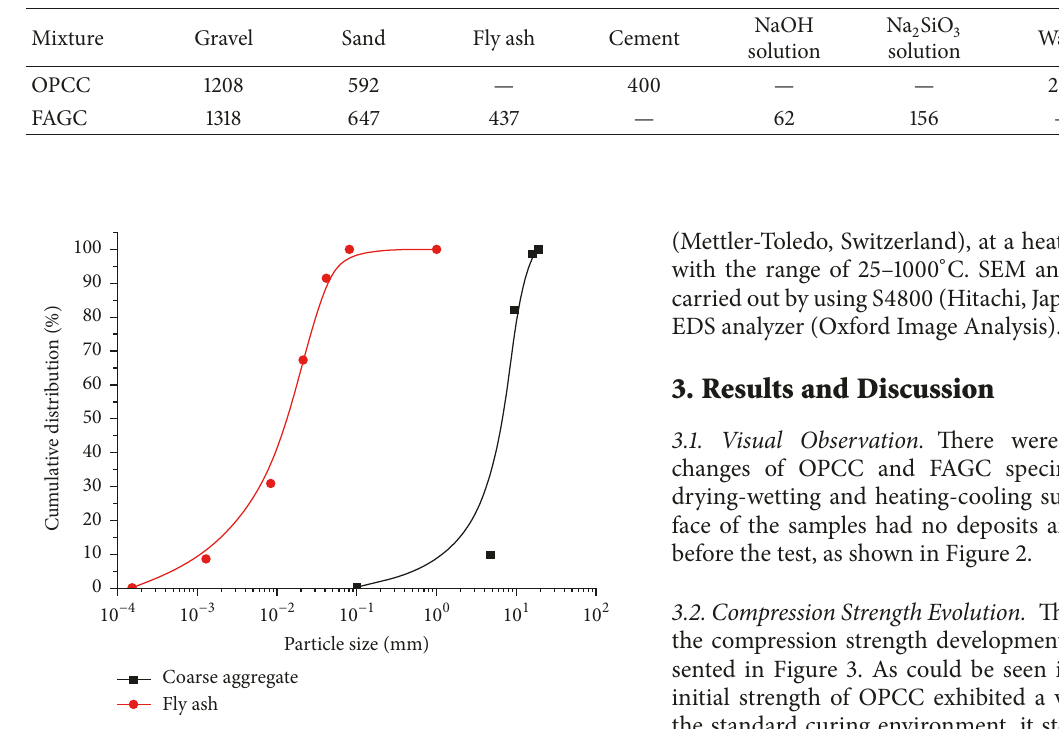
Figure 1: The gradation curve of fly ash and coarse